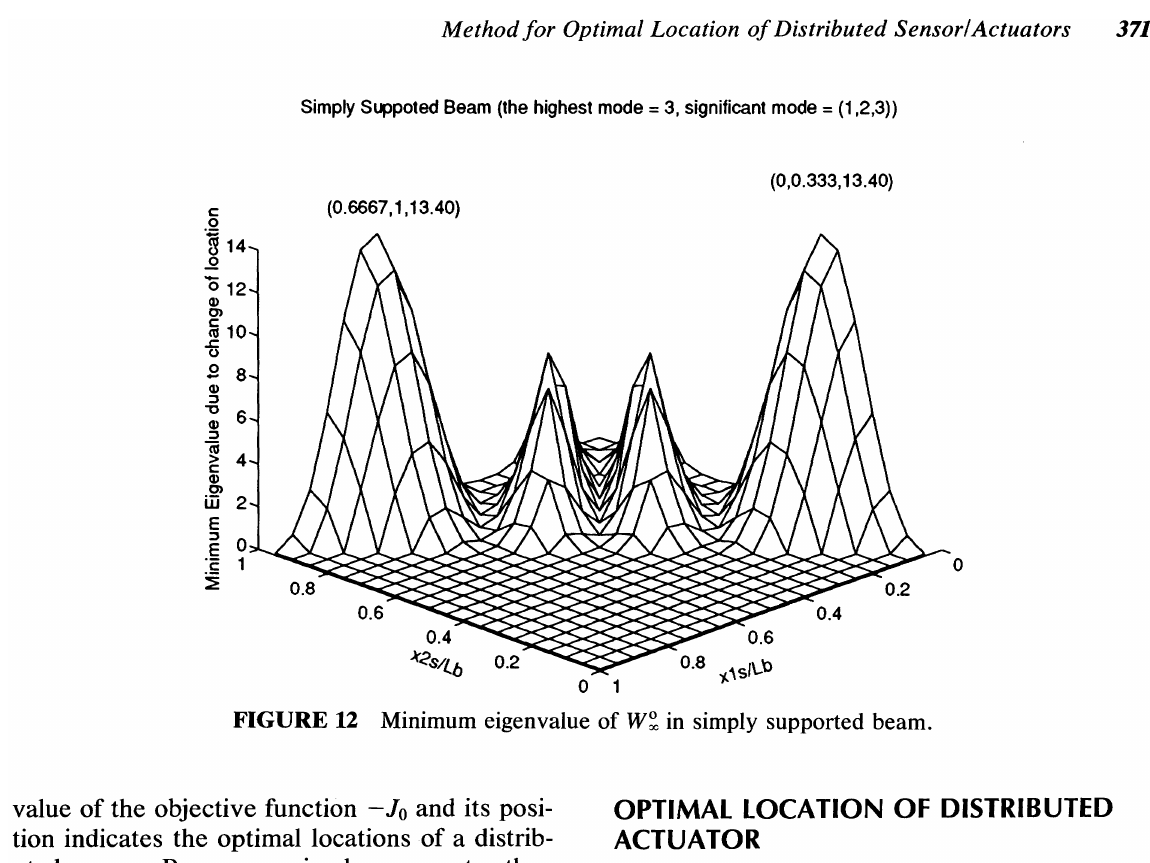
FIGURE 12 Minimum eigenvalue of W~ in simply supported beam.